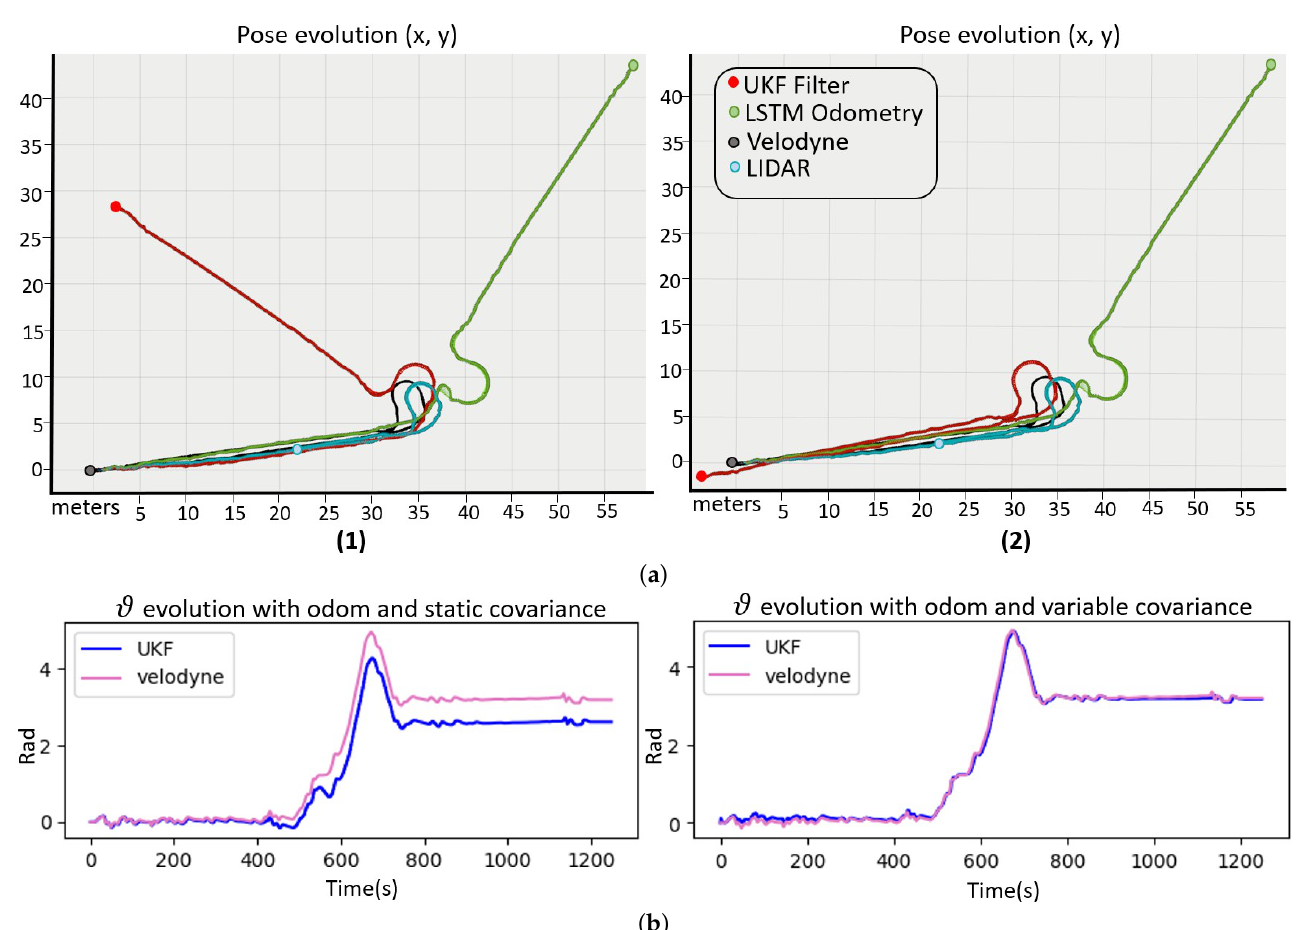
Figure 10. Localization system for a path where the red line is the filter output, the green is the odometry, the blue the LIDAR, and the black line for the ground truth. ( a ) Shows the position “X, Y” and ( b ) shows the orientation “ θ ”. ( 1 ) Odometry with static covariance and ( 2 ) odometry with variable